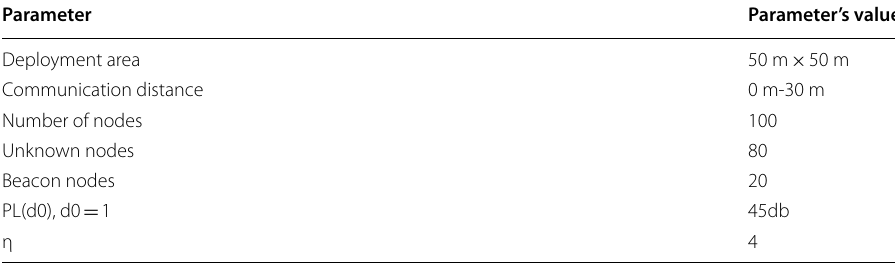
Table 2 Simulation parameters Parameter